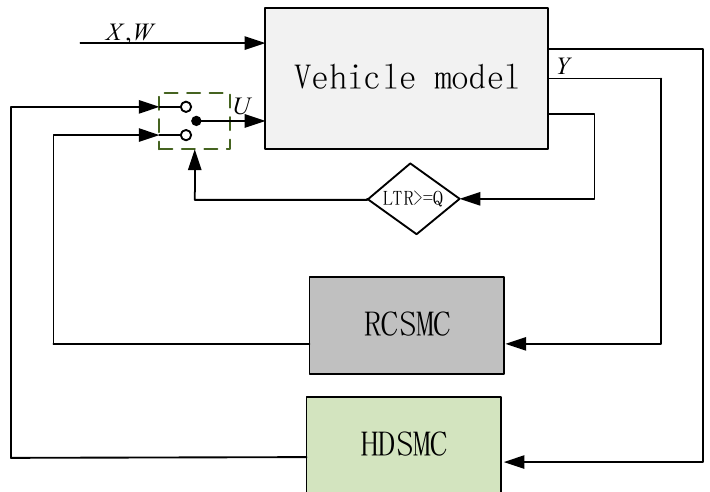
Figure 6. Dynamic switch control block diagram of the hydro-pneumatic suspension system.